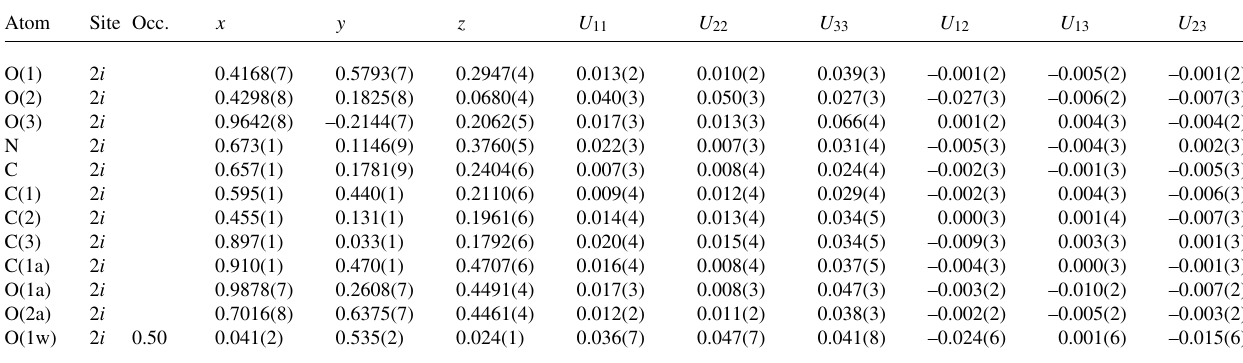
Table 3. Atomic coordinates and displacement parameters (in Å 2 ) .